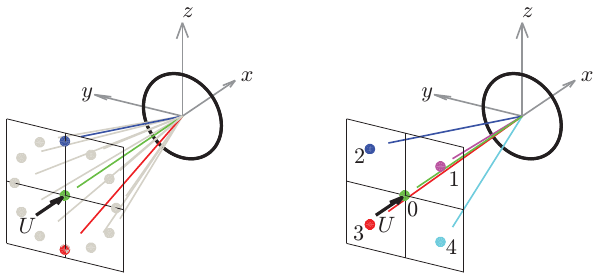
Figure 1. Geometry of the rotor and nacelle lidars. The x axis is Figure1. in the mean wind direction. The lidar beams point upwind in the determinedbytheunitvectors n i .FortheCWlidar(leftframe)weincludeabeamperpendiculartotherotorforcomparisononly.Forthe directions determined by the unit vectors n i . For the CW lidar (left pulsedlidar(rightframe)weshowa5-beamconfigurationwherebeam0isperpendiculartotherotor.Beamsperpendiculartotherotorare showningreen(beam0),topbeamsinblueandmagenta(beams1and2),bottombeamsinredandcyan(beams3and4),andotherbeams frame) we include a beam perpendicular to the rotor for compari- ingrey son only. For the pulsed lidar (right frame) we show a five-beam configuration where beam 0 is perpendicular to the rotor. Beams The i th lidar beam points to the direction defined by the unit vector n i ( i =1 ,...,N ). The unit vector can be expressed as perpendicular to the rotor are shown in green (beam 0), top beams n =( cos ϕ, sin ϕ cos θ, sin ϕ sin θ ) ,where θ istheanglebetweenthe y -axisand n projectedontothe y - z -plane.Forthebeam − in blue and magenta (beams 1 and 2), bottom beams in red and cyan 1 , 0 , 0) . If we assume that the lidars measure at a point, instead of over a probe volume, and perpendicular to the rotor n =( − (beams 3 and 4), and other beams in thatthe u -, v -,and w -componentsdonotchangeoverthescannedarea,theradialvelocityofthelidarbeamsoverthescanned circlecanbeestimatedas 5